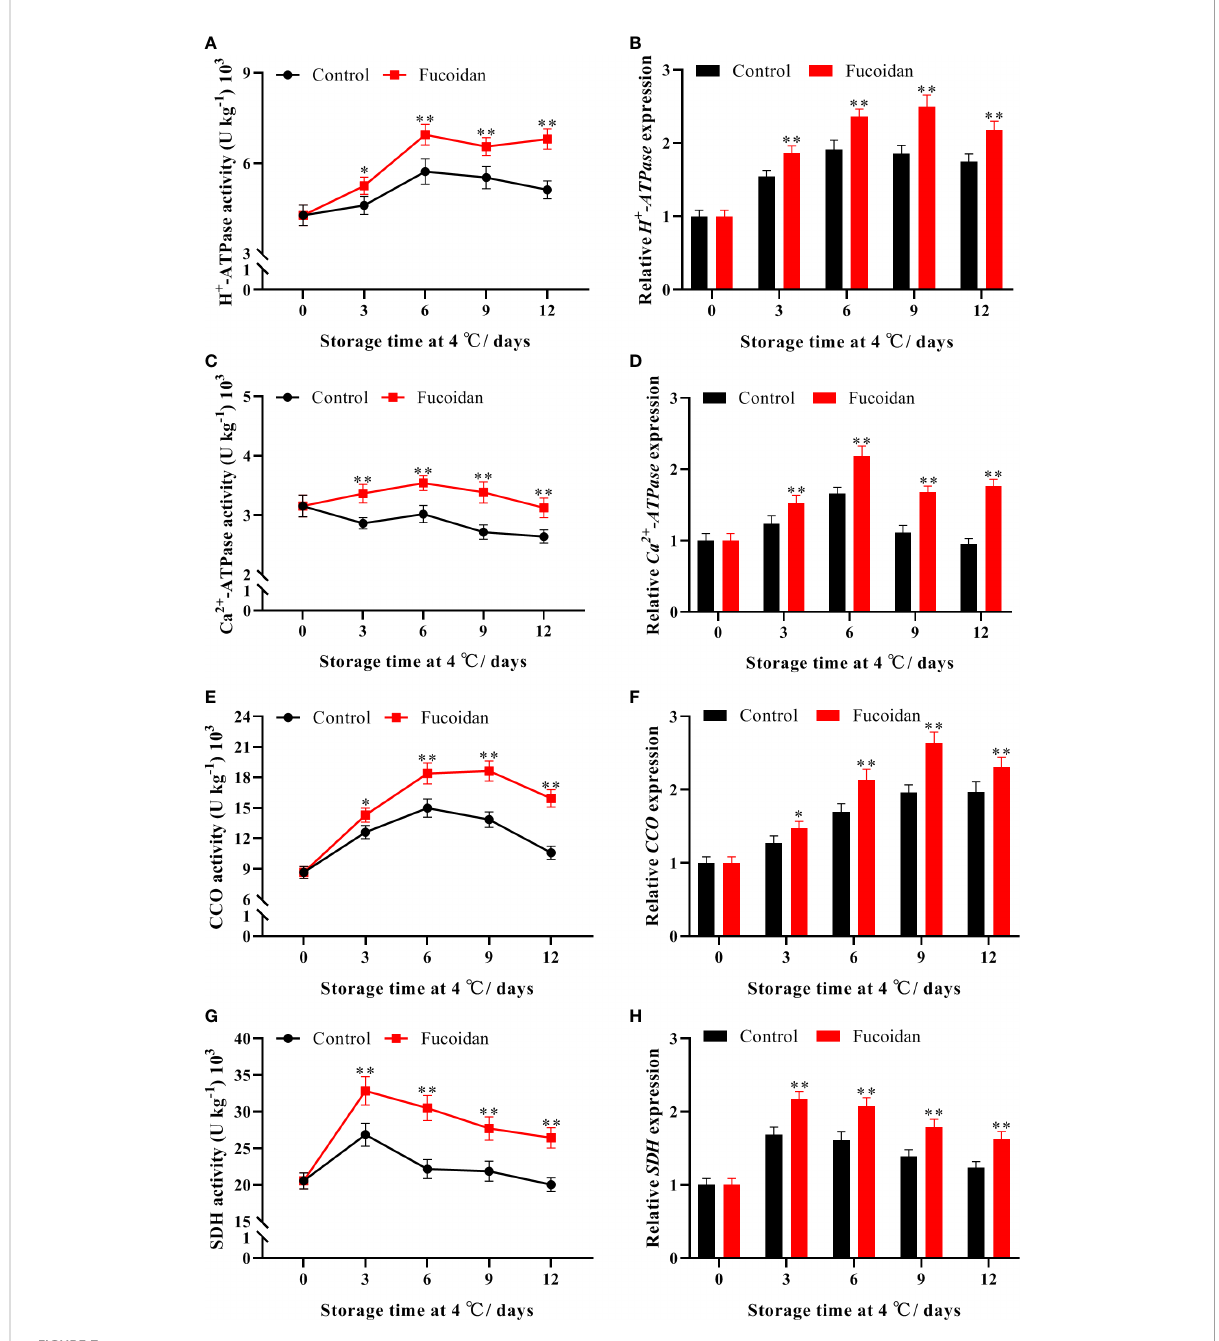
FIGURE 7 (A-H) The enzyme activities and gene expression of H + -ATPase (A, B) , Ca 2+ -ATPase (C, D) , CCO (E, F) , and SDH (G, H) in fucoidan-treated (15 g L -1 ) and control cucumbers during storage at 4°C. Values are presented as means ± SD of at least three replicates. *P< 0.05; **P<